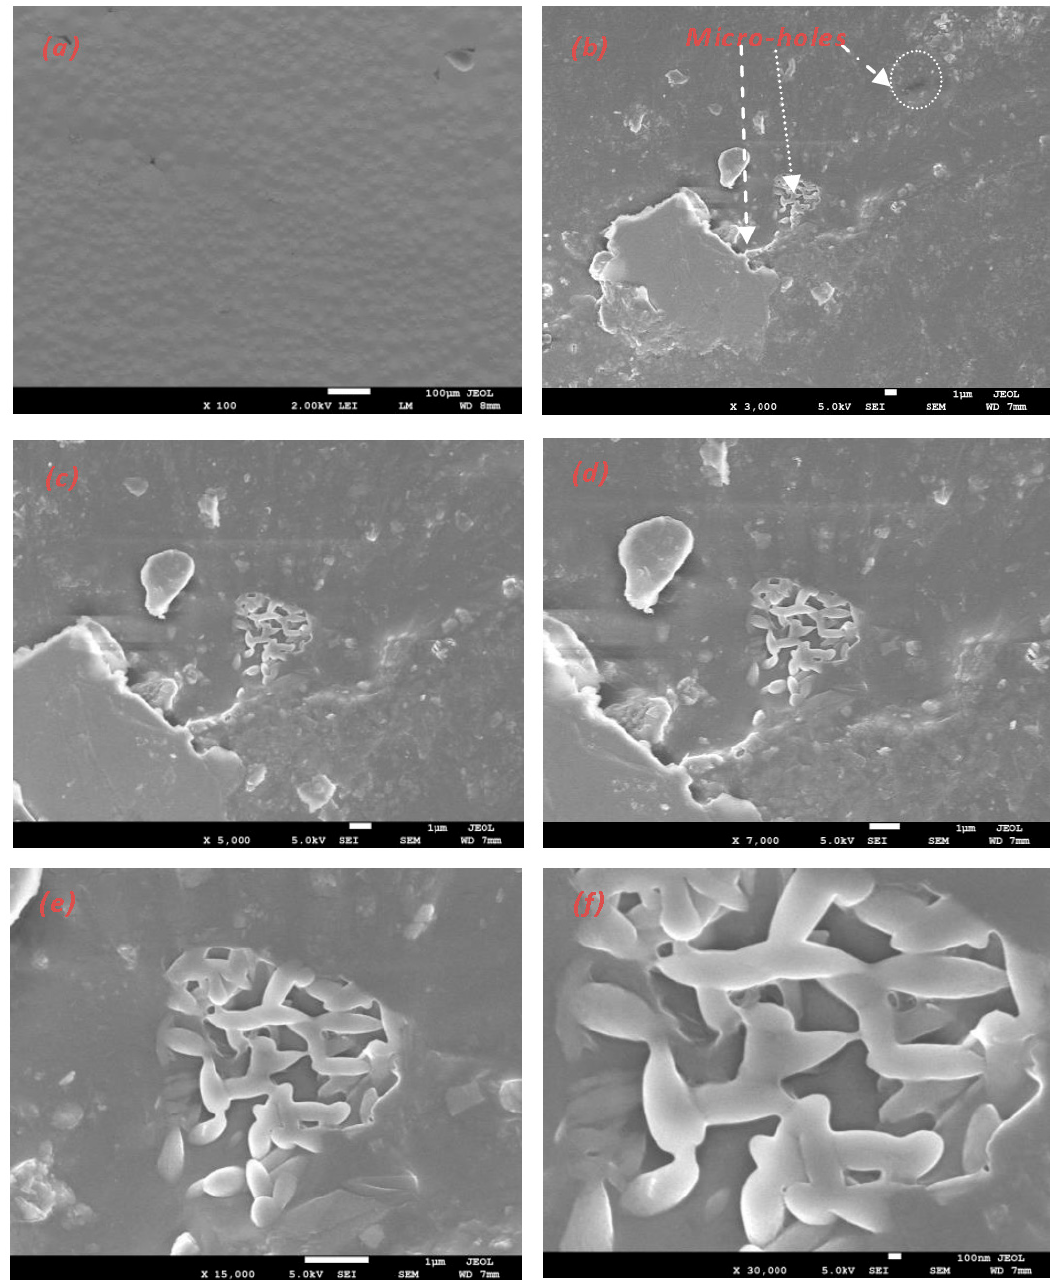
Figure 6. Scanning electron micrograph of the surface images of the blend-3 film; ( a ) before the degradation; ( b – f ) after immersion in wastewater for eight weeks with different scales.